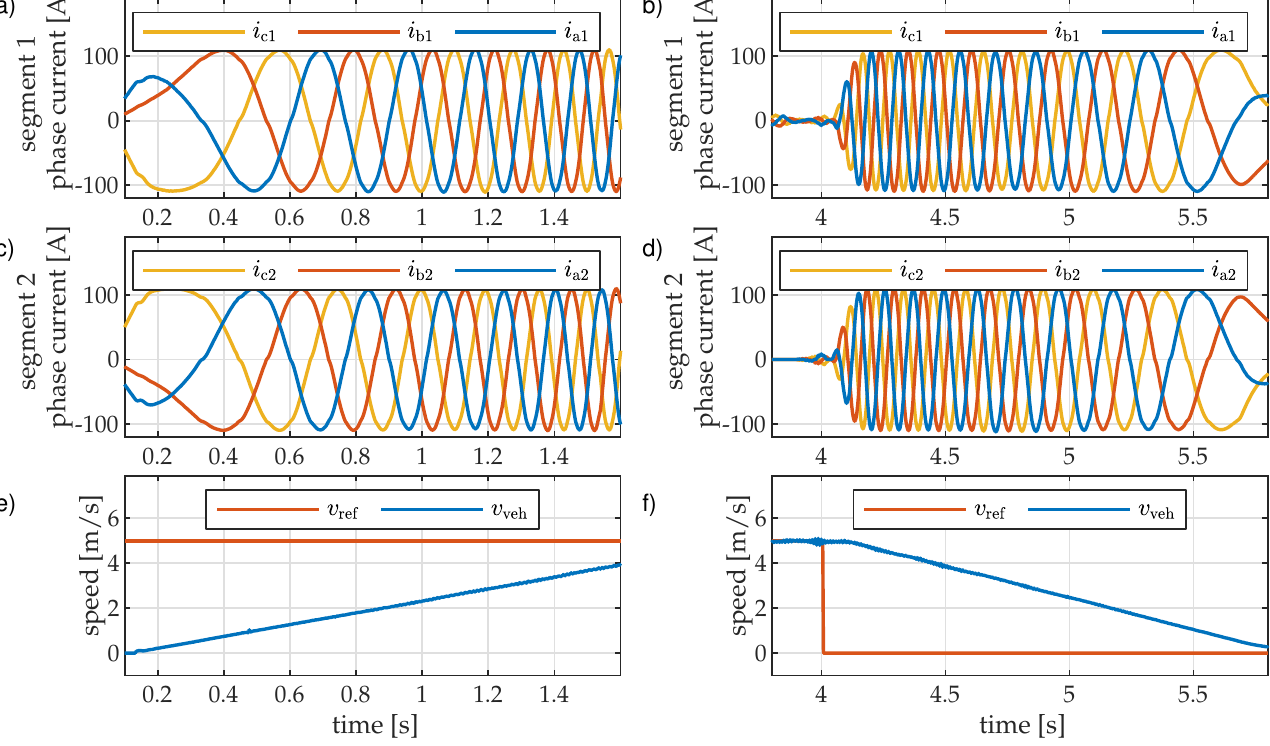
Figure 19. Experimental results for dual-inverter configuration, left column—acceleration, right